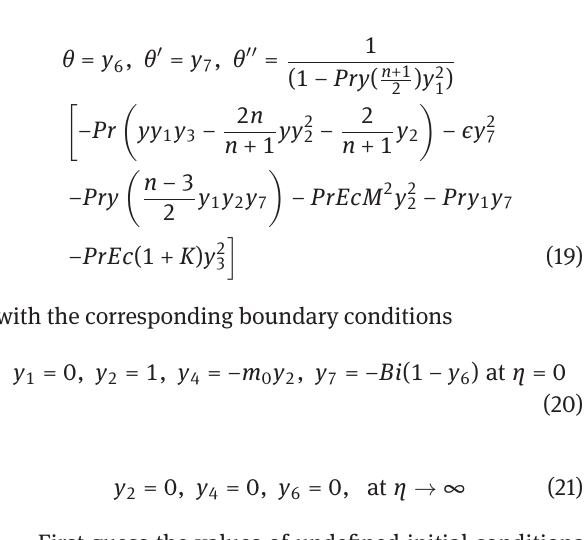
Fig. 2: Impact of M on